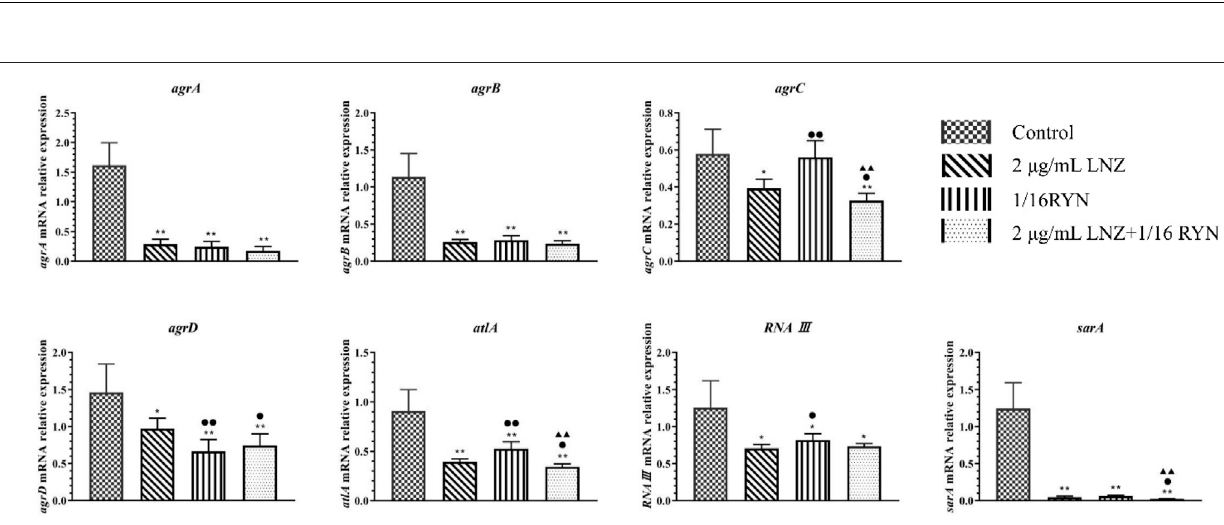
Frontiers in Pharmacology |